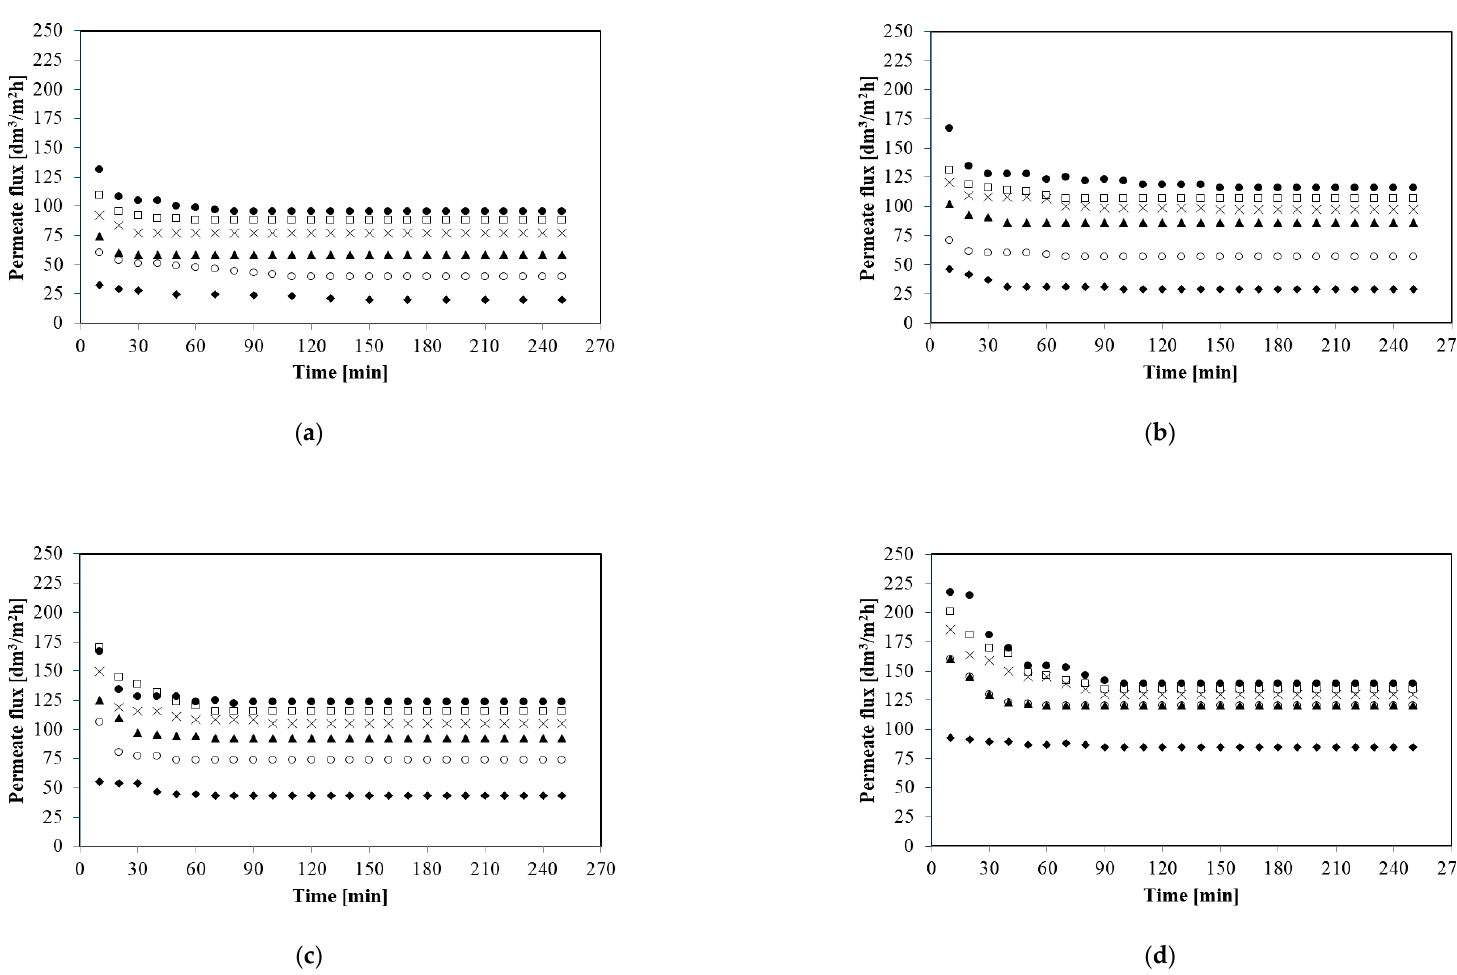
Figure 3. E ff ect of transmembrane pressure on the permeate flux. ( a ) 250 dm 3 / h; ( b ) 500 dm 3 / h; ( c ) 750 dm 3 / h; and ( d ) 1000 dm 3 / h. TMP [MPa]: (cid:95) 0.02, Figure 3. Effect of transmembrane pressure on the permeate flux. ( a ) 250 dm 3 /h; ( b ) 500 dm 3 /h; ( c ) 750 dm 3 /h; and ( d ) 1000 dm 3 /h. TMP [MPa]: × 0.08, (cid:3) 0.10, and •